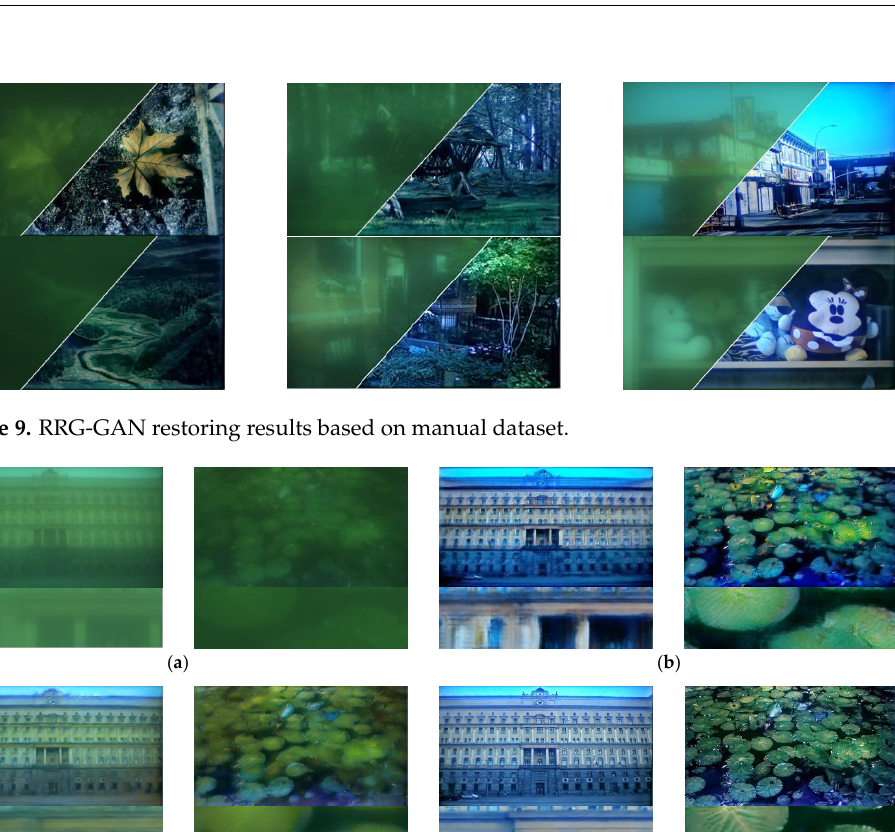
Figure 10. The results comparison using different deep-learning methods based on manual dataset: ( a ) Original blurry images; ( b ) FOV-GAN restoring results; ( c ) DeblurGAN-v2 restoring results; ( d ) Our proposed RRG-GAN restoring results.